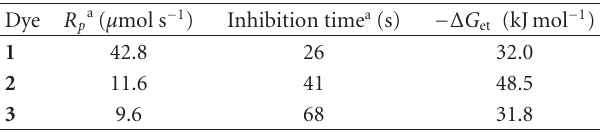
Table 2: Rate of photopolymerization, inhibition time, and ther- modynamic parameters of studied photoredox pairs.